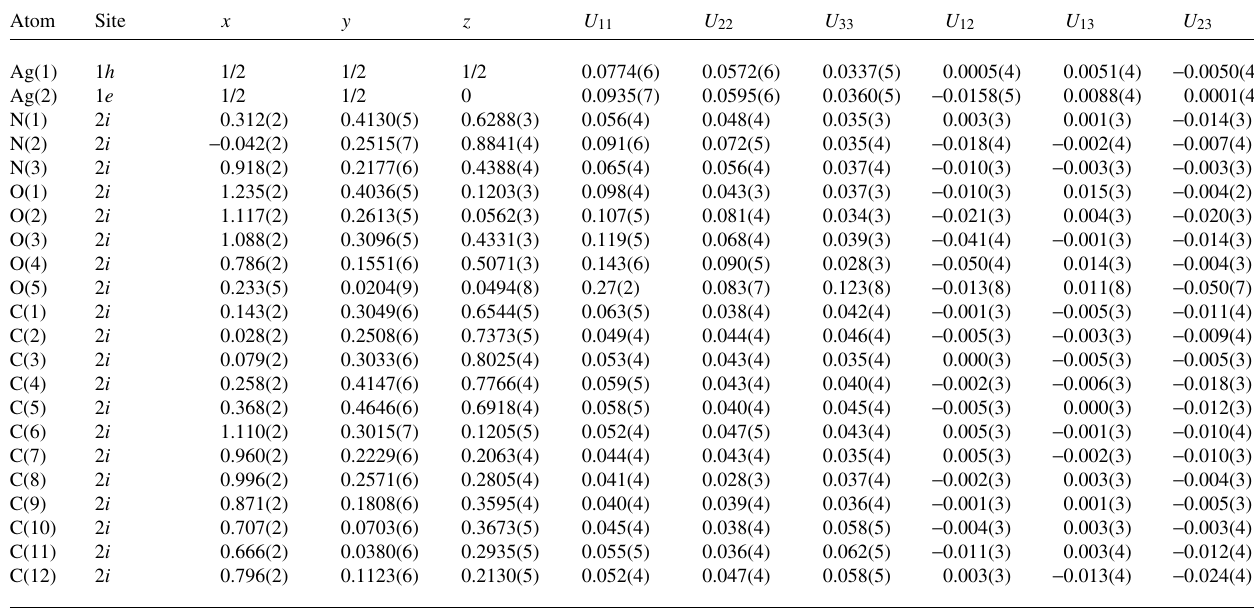
Table 3. Atomic coordinates and displacement parameters (in Å 2 ) .